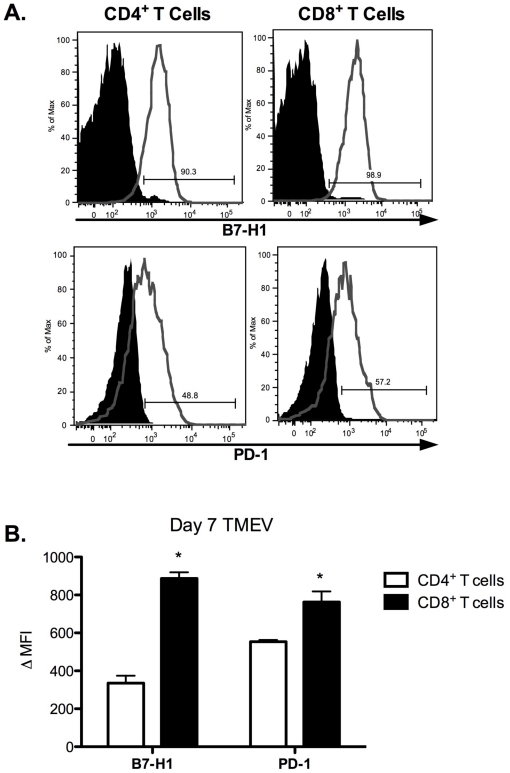
B7-H1 and PD-1 expression are highly upregulated on CD4+ and CD8+ CNS T cells from TMEV-infected SJL/J mice.CNS T cells from wild-type SJL/J mice at day 7 post-TMEV infection were analyzed for expression of B7-H1 and PD-1 molecules by flow cytometry. A. Histograms of B7-H1 and PD-1 expression on CD4+ and CD8+ T cells. Black shaded area represents isotype control and the grey line represents positive staining. A representative histogram from one individual mouse from three separate experiments is shown. B. Data is also represented as Δ mean fluorescence intensity (ΔMFI) of B7-H1 and PD-1 expression on CD4+ and CD8+ T cells. Expression of B7-H1 and PD-1 is significant greater (*p<0.05) on with CD8+ as compared to CD4+ T cells. Data are expressed as the average ± SEM.